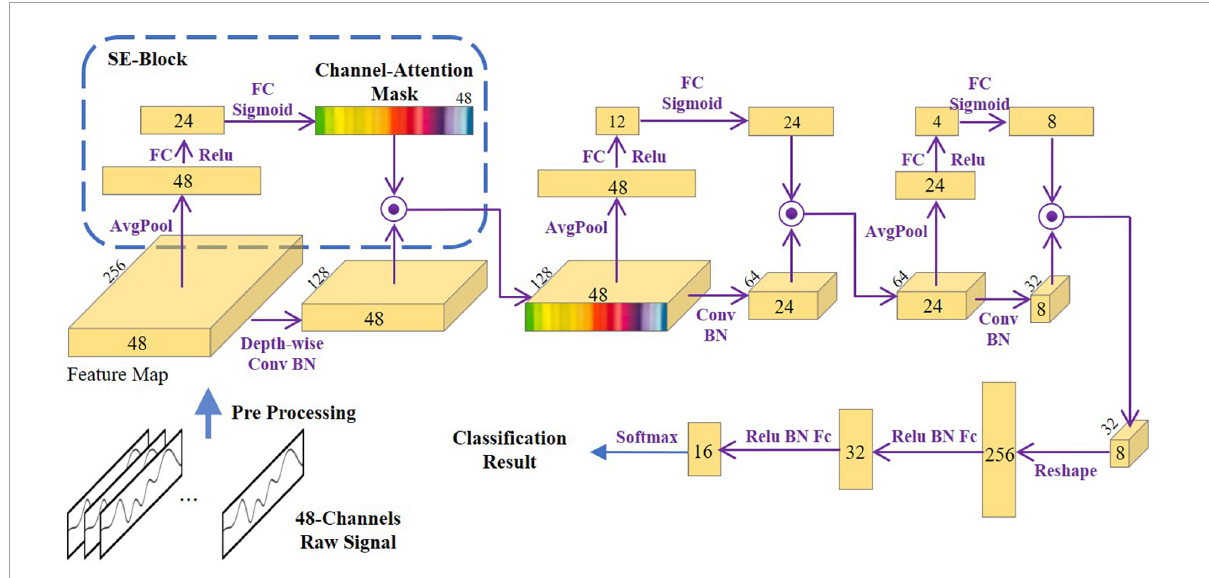
FIGURE4 The structure of the attention-based convolutional neural network.